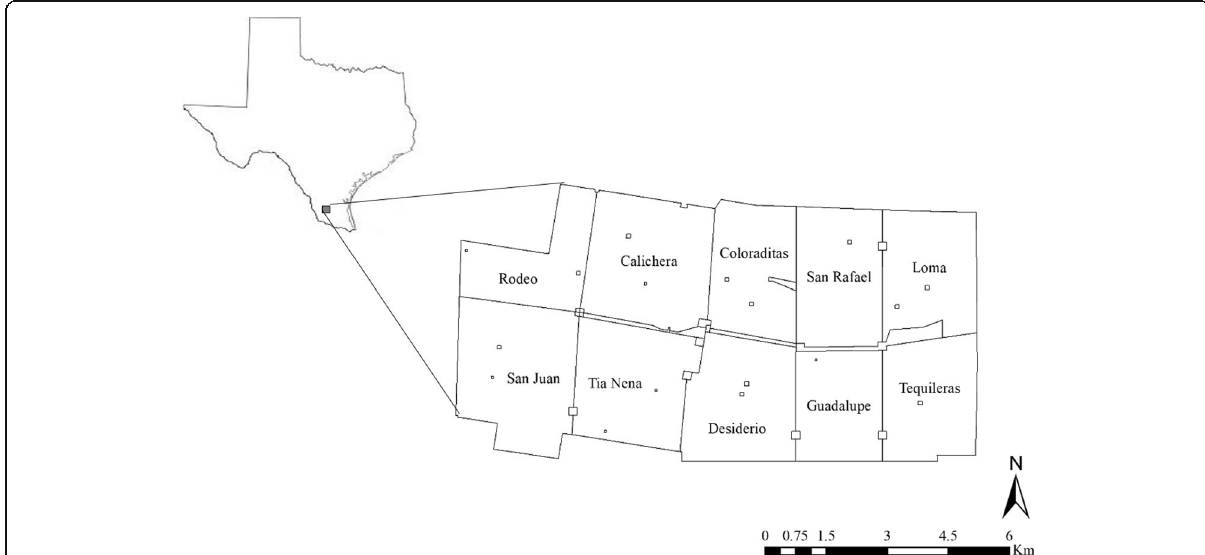
Fig. 1 Locality and pasture composition of East Foundation ’ s Coloraditas Grazing Research and Demonstration Area (CGRDA). Four pastures were assigned to a continuous grazing system with 2 pastures (Rodeo and Tia Nena) maintained under a high stocking rate (1 Animal Unit [AU]/14 ha) and 2 pastures (San Juan and Calichera) under a moderate stocking rate (1 AU/20 ha). Six pastures were assigned to a rotational system with 3 pastures, 1 herd maintained under the high stocking rate (Coloraditas, Desiderio, and Guadalupe units) and 3 pastures, and 1 herd maintained under the moderate stocking rate (San Rafael, Loma, and Tequileras